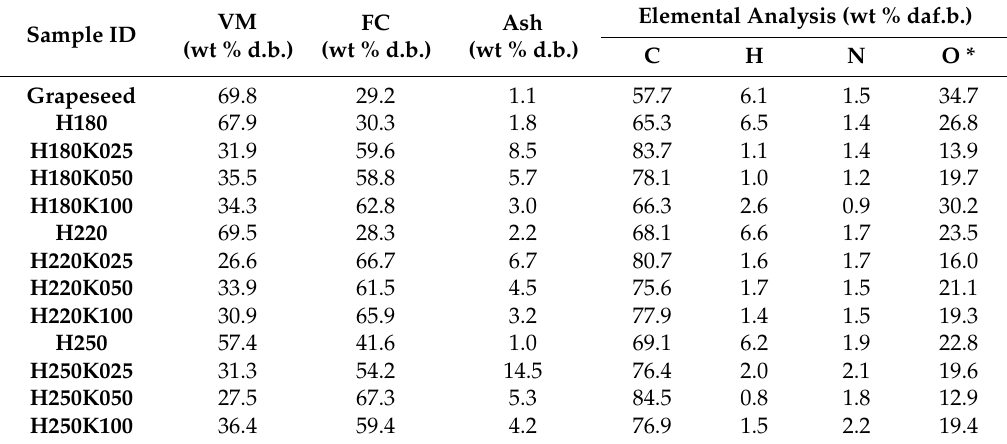
Table 3. Proximate and ultimate analyses of the hydrochar and grape seeds activated carbon (GSAC)